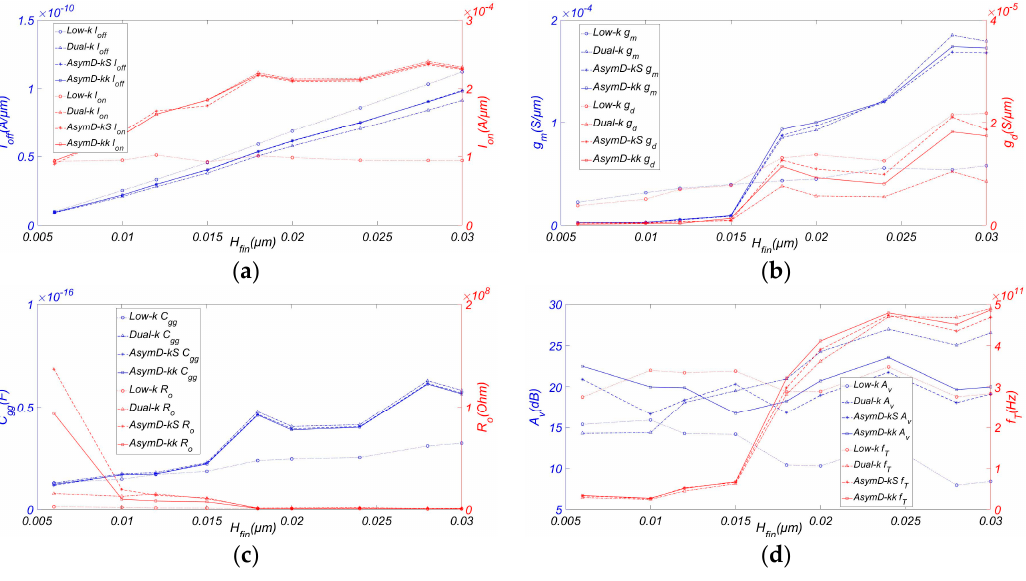
Figure 3. Variation of ( a ) I off and I on ( b ) g m and g ds , ( c ) C gg and R o , ( d ) A v and f T of FinFET with AR. Simulated with W fin = 6 nm, L ext = 20 nm, T ox = 0.8 nm, L hk = 12 nm, σ L = 3 nm, and V ds = 0.9 V.